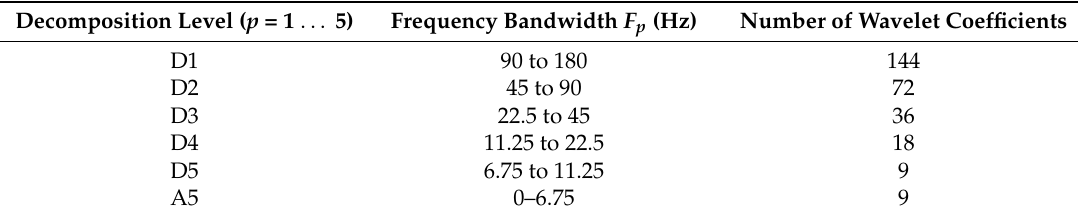
Table 3. Number of wavelet coefficients at each frequency sub-band. Decomposition Level ( p = 1 . . . 5)